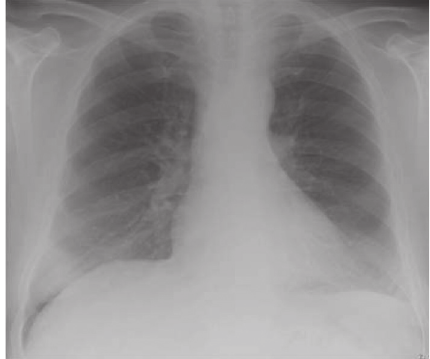
Figure 6: Repeat CXR from last outpatient assessment.